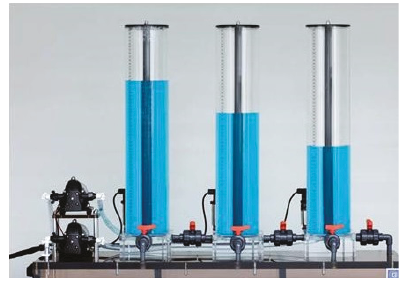
Figure 1: TTS20-tank tank.